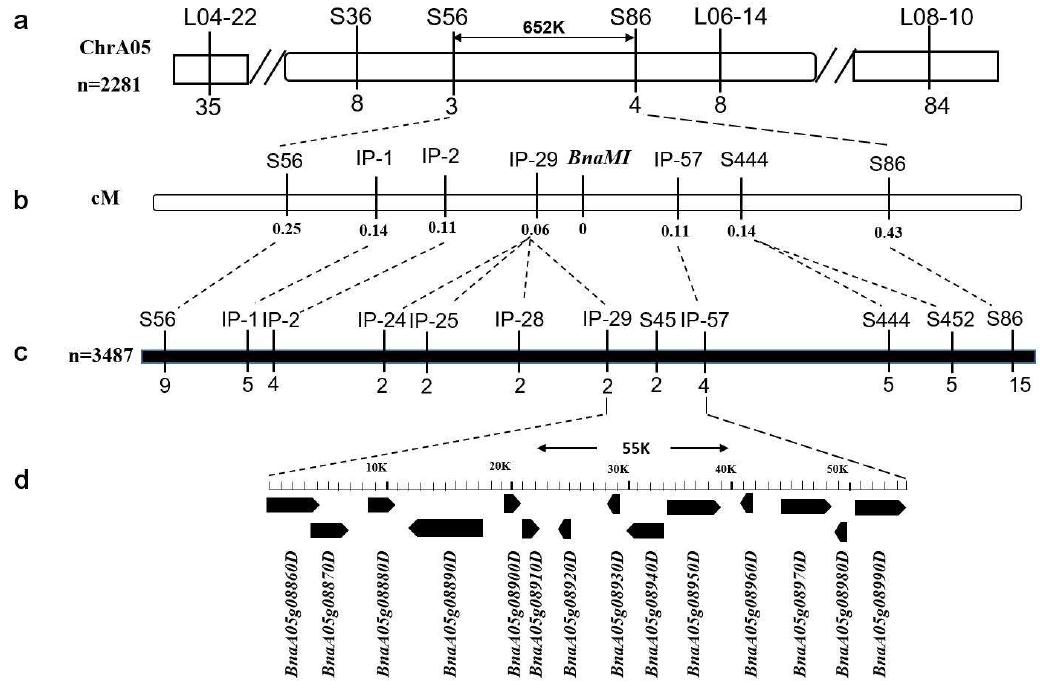
Figure 3. Fine mapping of BnaMI gene. ( a ) Initial mapping of BnaMI using 2281 BC 3 F 1 individuals. The applied markers are above the chromosome, and the number of recombinants in this population is marked below. ( b ) The genetic linkage map of BnaMI . The values under the markers indicate centimorgan values. ( c ) Fine mapping of BnaMI using 3487 BC 4 F 1 individuals. The markers are arranged according to their physical positions on the chromosome and the numbers below the makers indicate the number of recombinants. ( d ) Annotation in 55 K region according to Darmor ( Bnassica napus cultivar) reference genome. The black boxes represent the candidate genes predicted in Darmor database.